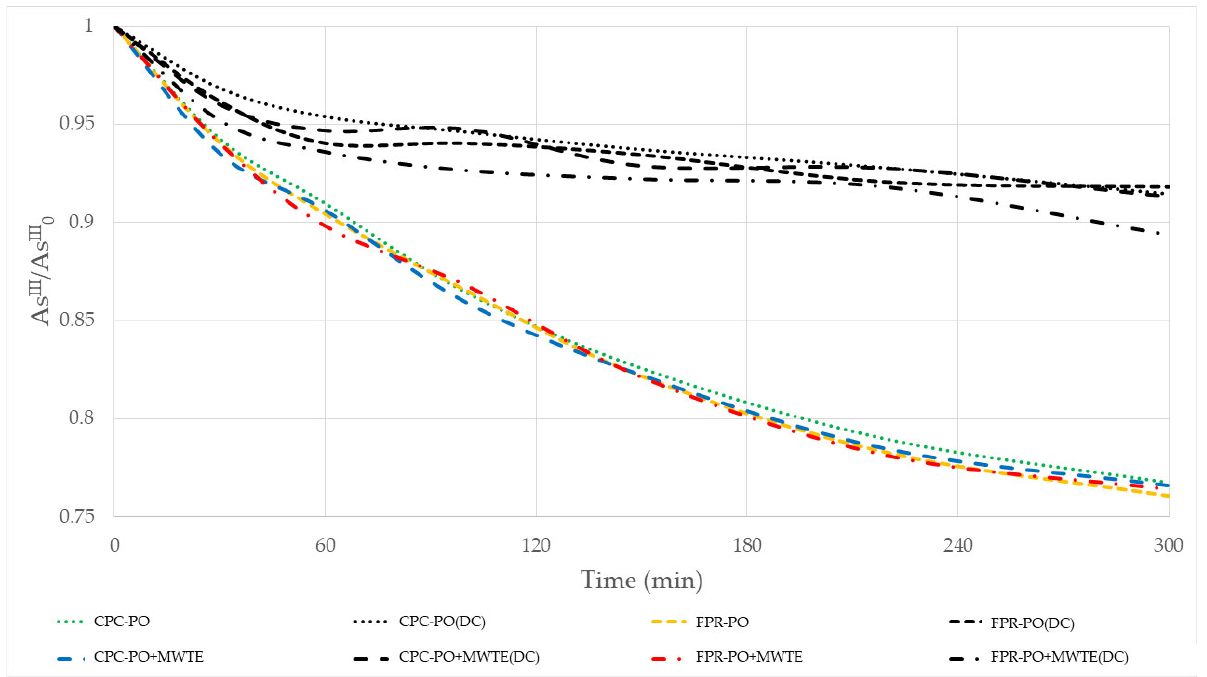
Figure 4. As III photooxidation (PO) experiments carried out both in CPC and FPR, with and without MWTE spike. Experiments performed in the dark as control experiments (DC) are included as well.